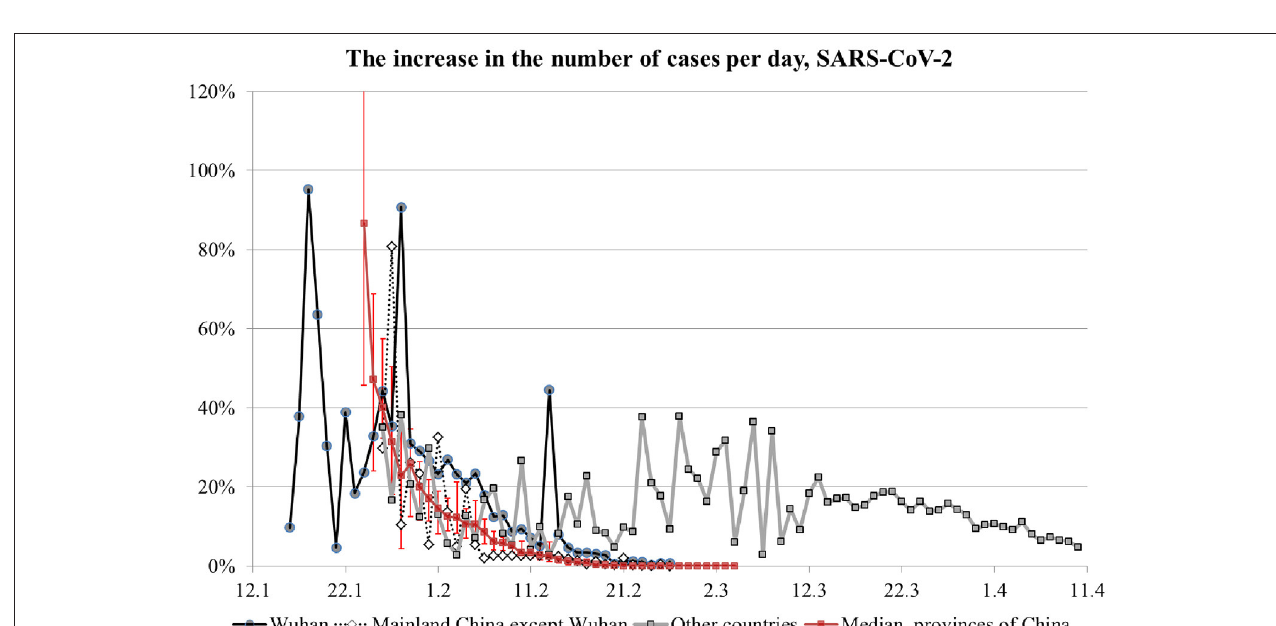
FIGURE 2 | Incidence rate growth rate in different